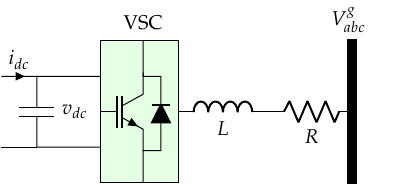
Figure 4. Typical interconnection of a PV plant through a